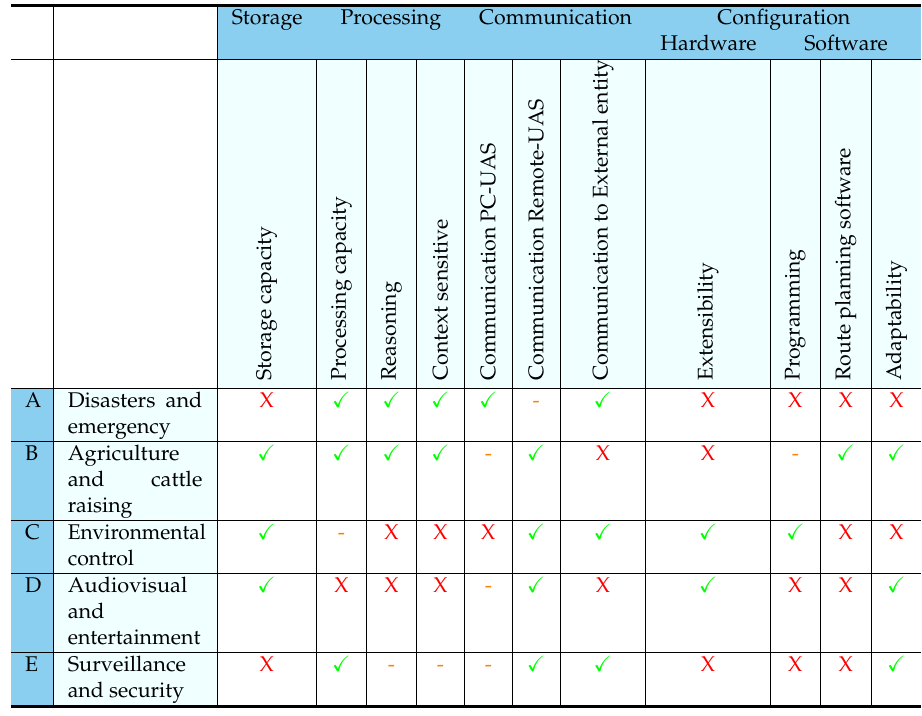
Table 3. Use case categories and features included in